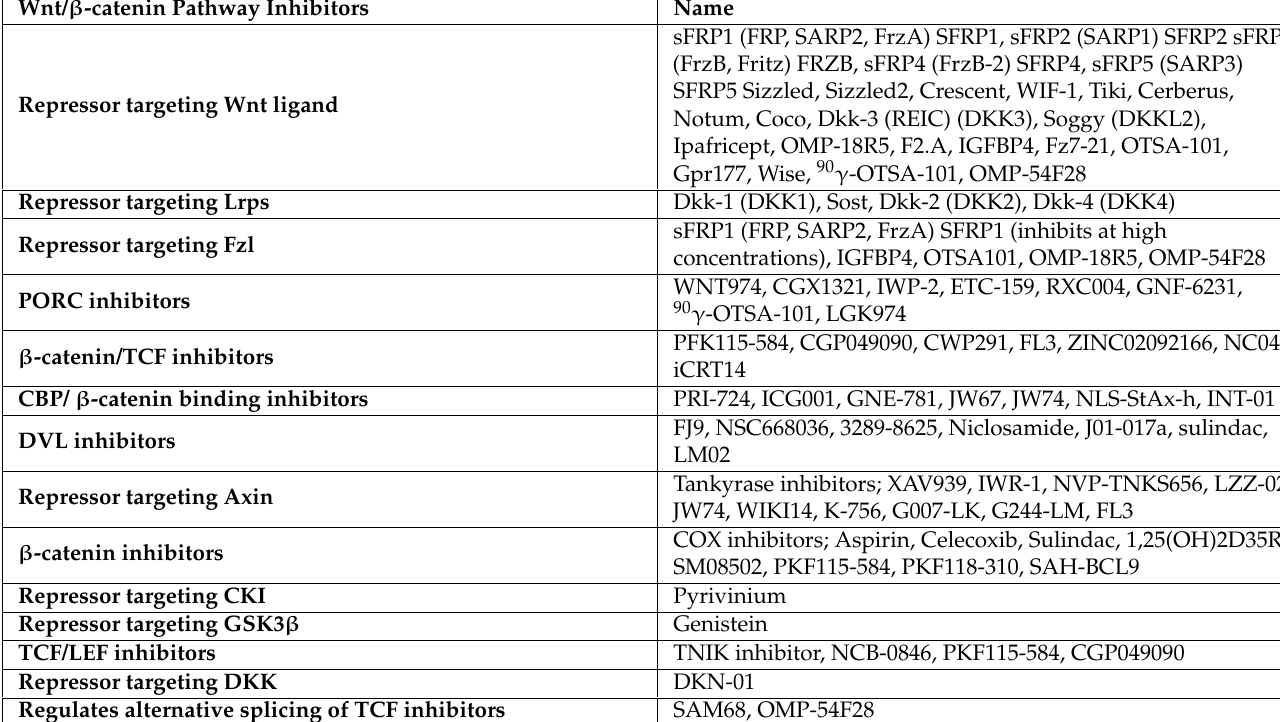
Table 1. Wnt/ β -catenin signaling